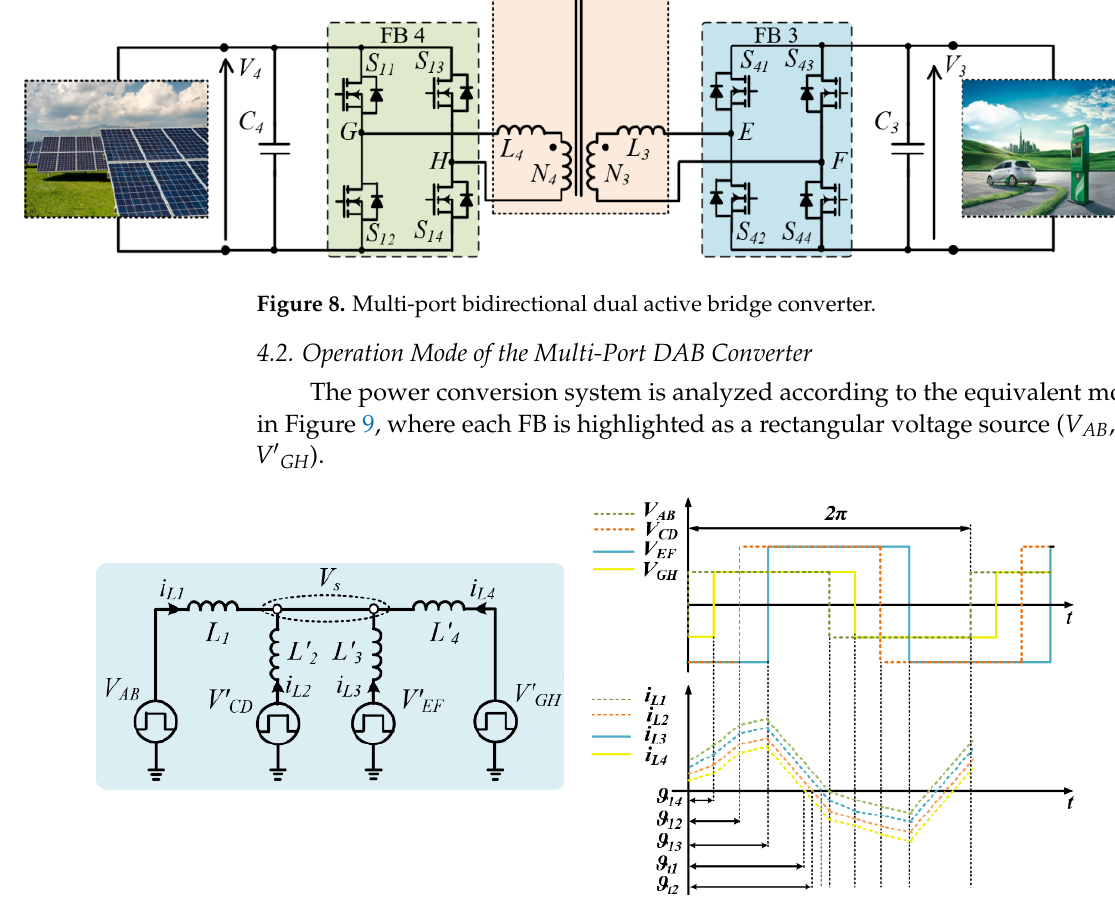
Figure 9. Equivalent circuit of the multi-port DAB converter.